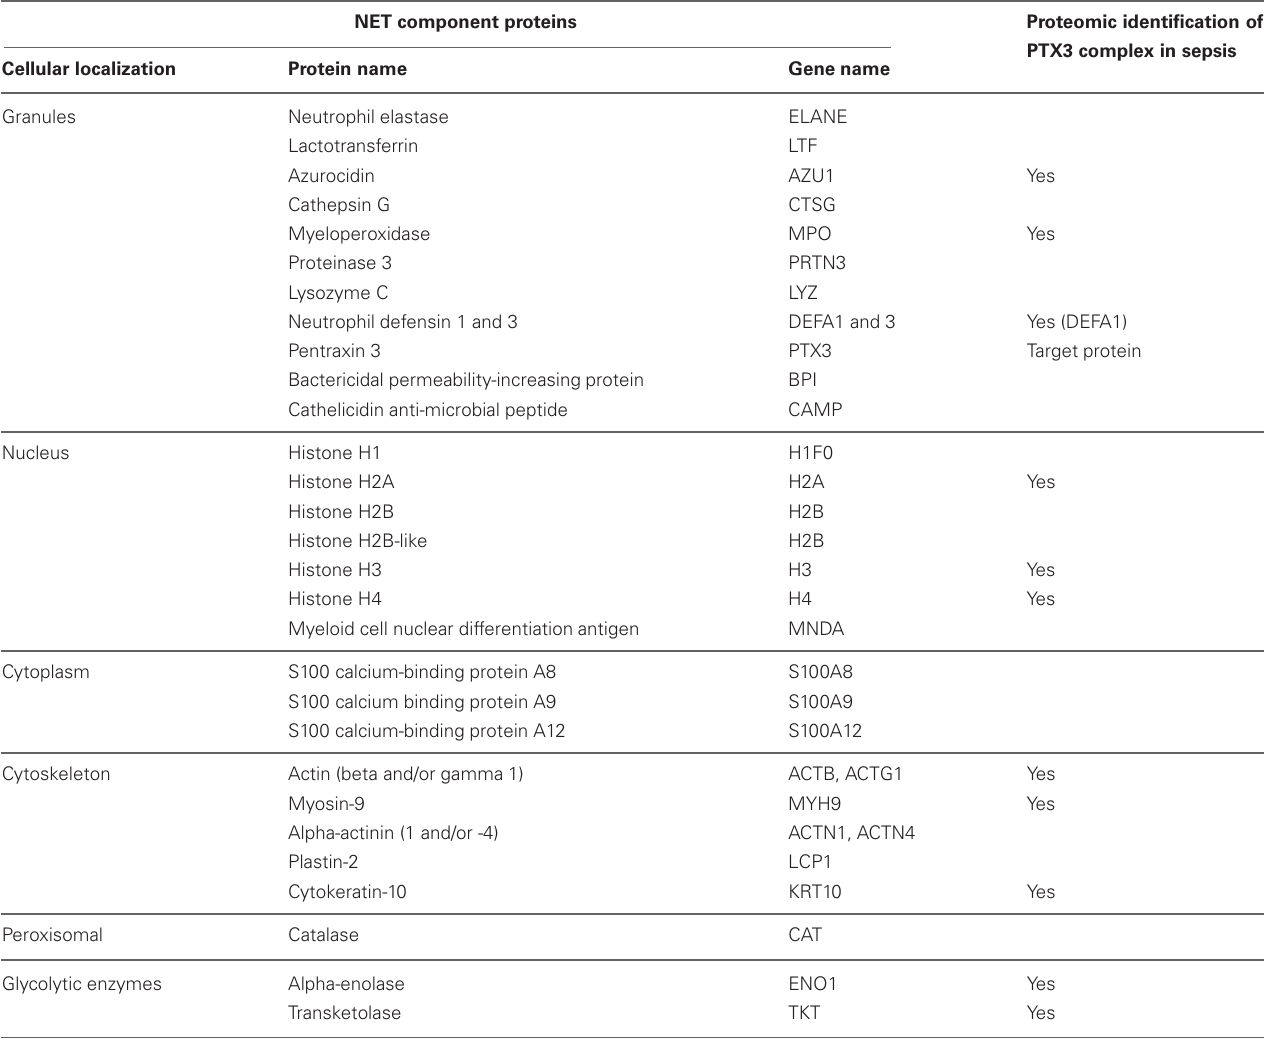
Table 3 | List of the NET component proteins and proteins belonging to the PTX3